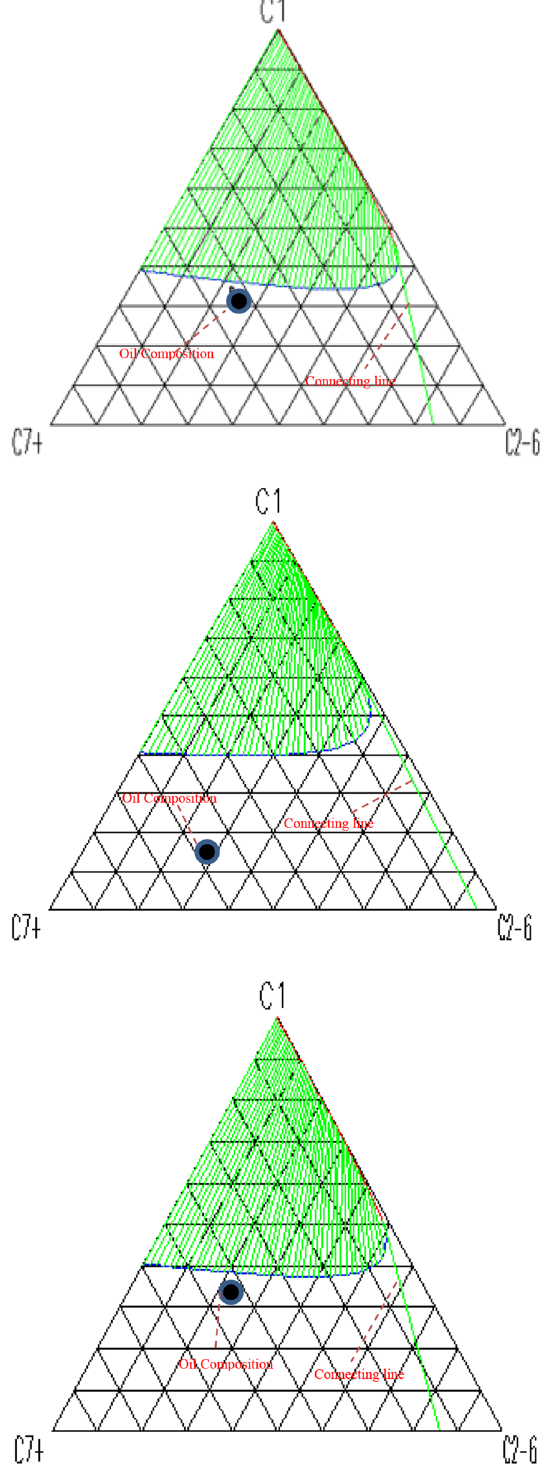
Fig. 5 Schematic ternary diagram for SI (top), S2 (middle) and S3 (bottom) oil